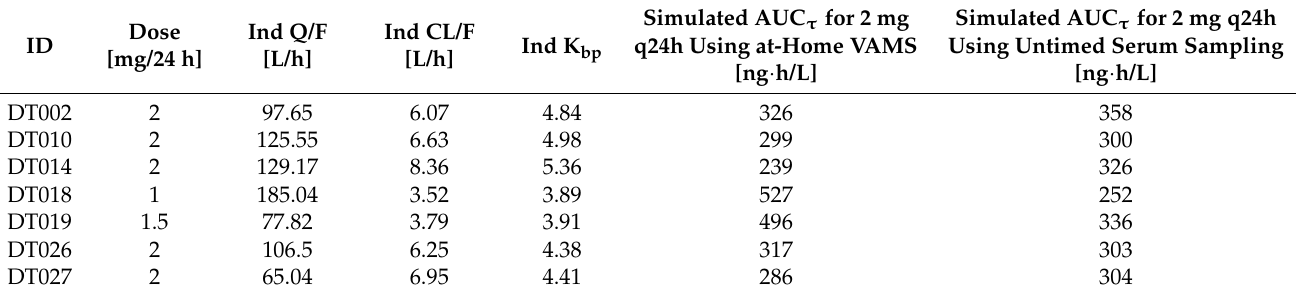
MAP estimates for trametinib serum pharmacokinetic parameters using at-home sampled